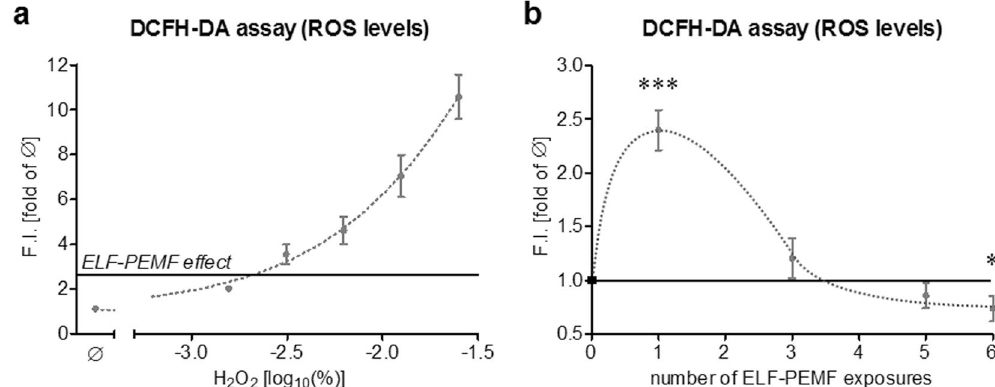
Figure 2. Effect of single and repetitive exposures to ELF-PEMF on ROS formation in hOBs. ( a ) Comparison of the ROS level in hOBs (N = 6, n = 4) after single exposure to ELF-PEMF (black line) and stimulation with different concentrations (0, 0.0015625, 0.003125, 0.00625, 0.0125 and 0.025%) of H 2 O 2 . ( b ) ROS levels in hOBs (N = 12, n = 4) after single and repetitive exposures to ELF-PEMF (7 min per day). ROS levels were determined using the DCFH-DA assay. Results are given as fold of unstimulated hOBs (Ø). * p < 0.05 and *** p < 0.001 as compared to corresponding unstimulated hOBs (two-tailed Mann-Whitney test, α =